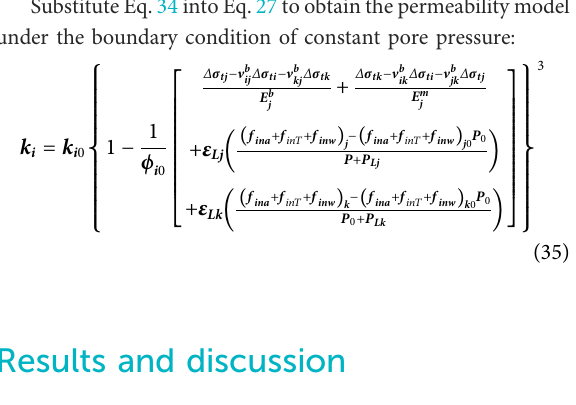
converted to k / k 0 and then fi tted by the permeability model (Figure 4). The experimental data has a high correlation with this model, the correlation coef fi cients are all greater than 0.99. It indicates that the anisotropic permeability model can be used to predict the change of isotropic permeability if the difference of mechanical parameters in different directions is ignored. It can be seen that the k / k 0 gradually increases with the increase of CO 2 injection pressure. This is because the CO 2 injection causes the closed fractures to reopen. At the same time, the coal matrix swells to the outside, resulting in the widening of the fractures and improving the permeability of coal.